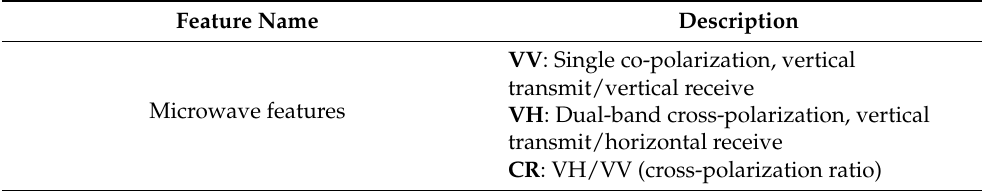
Table 3. Microwave indicators derived from S1 in the year 2018 and used for LULC classification.